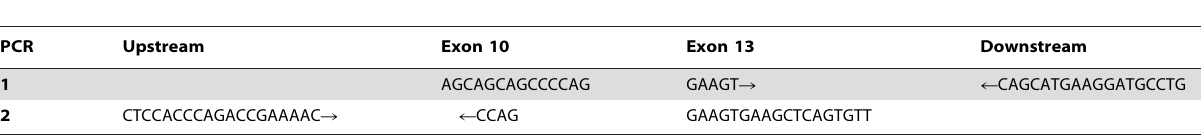
Table 3. Primers overlapping exons 10 and 13 to confirm the presence of p67delex11,12.